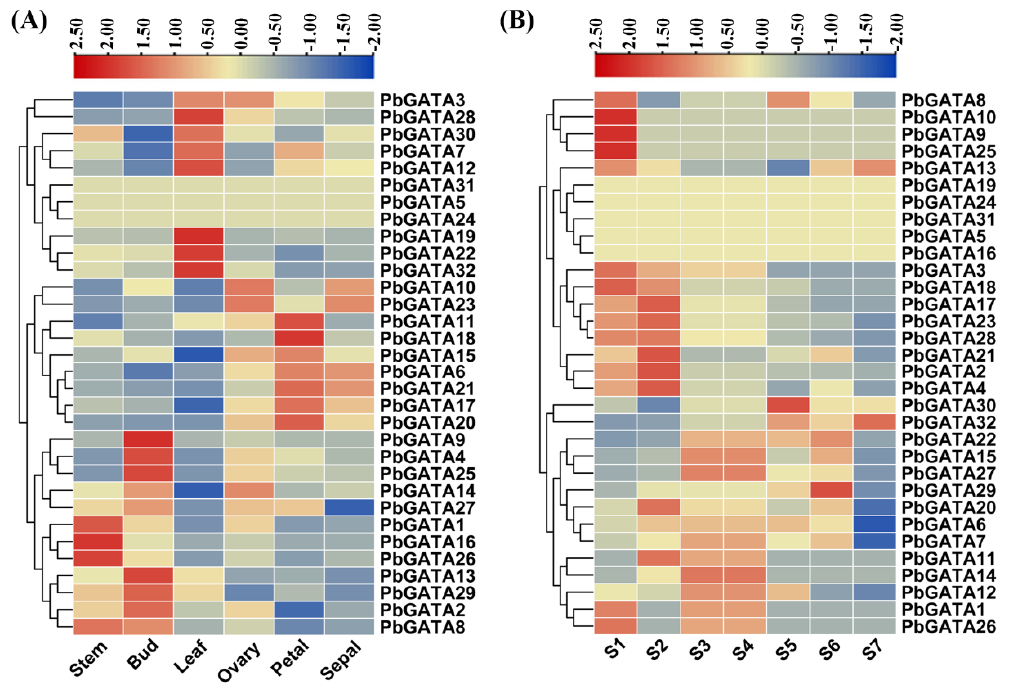
Figure 9. A heat map is visualized to demonstrate the relative expression patterns of GATA genes. ( A ) The transcription patterns of the GATA gene family in organs (leaf, ovary, sepals, petals, bud, and stem). ( B ) The fruit of Chinese pear at different developmental stages (S1 to S7). Different colors correspond to log2 transformed values. Blue or violet color indicates no or lower relative transcripts abundance of each sample and red showed higher expression respectively.